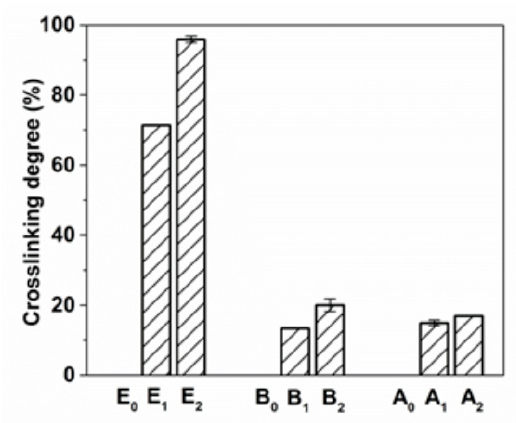
Figure 1. Crosslinking degree of different gelatin films.